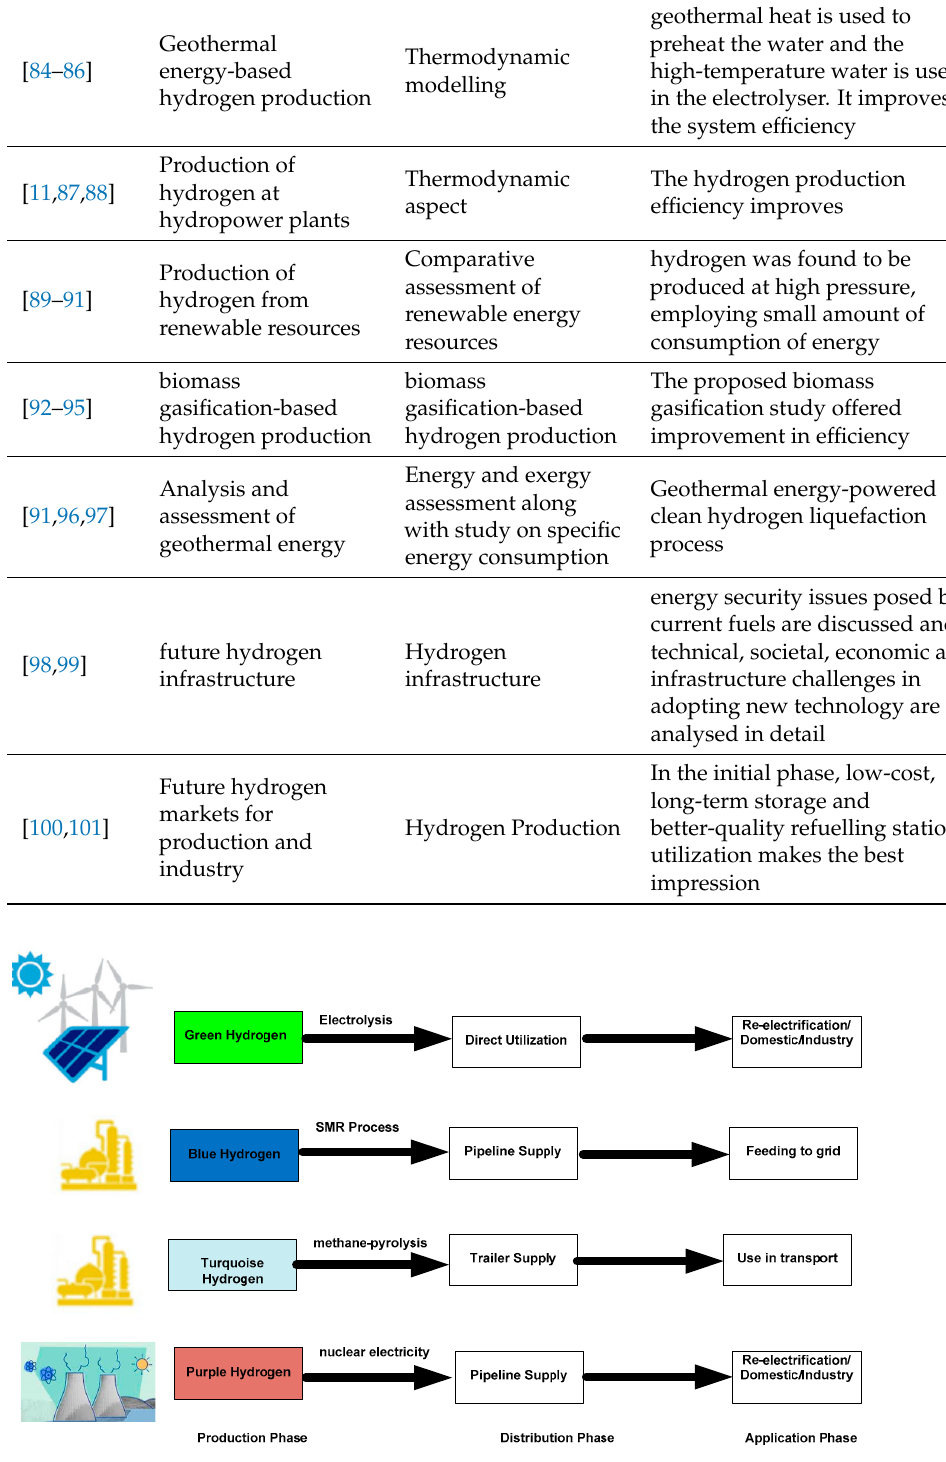
Figure 8. Summarized Hydrogen production methods.